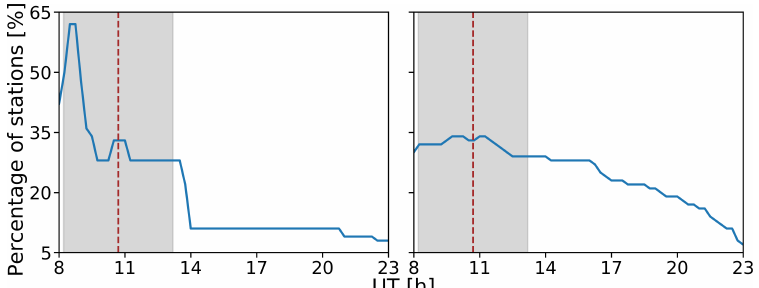
Figure 5. Time variations of the percentage of stations with 3D positioning error greater than 10 cm on DoY 161. The ( left panel ) shows the 36 GNSS stations localized in Greenland. The ( right panel ) presents the 335 GNSS stations that are situated in South America.